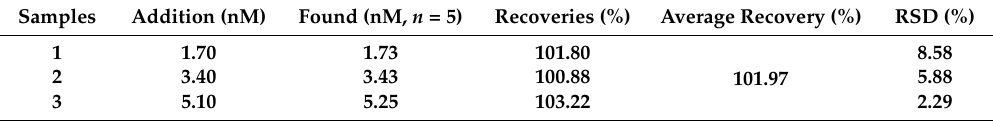
Table 1. Spike recovery test for the detection of NV RNA in normal human